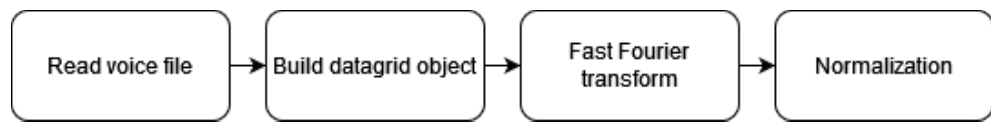
Figure 6. Data preprocessing